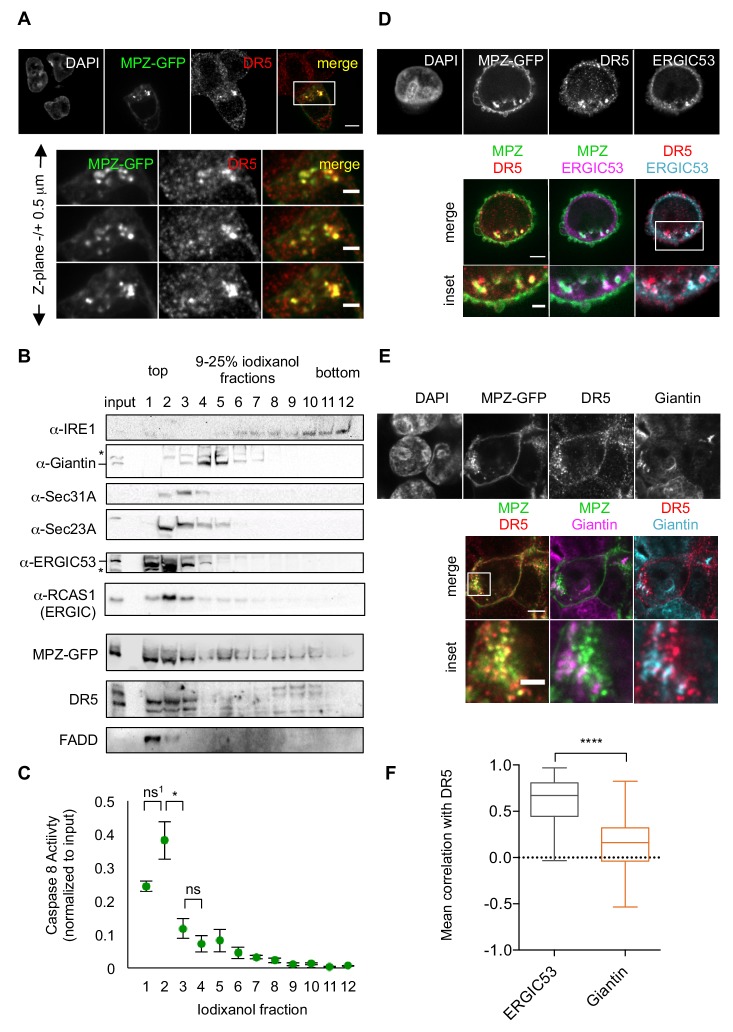
Misfolded protein engages DR5 at the ER-Golgi intermediate compartment, inducing active DR5 signaling clusters.(A) Top: Immunofluorescence of HCT116 cells transfected with MPZ-GFP (green) for 24 hr and stained with anti-DR5 (red, scale bar 5 μm). Bottom: Enlargements of the inset stepping through the z-plane in 0.5 μm increments (scale bar 2 μm). (B) Subcellular fractionation of lysate expressing MPZ-GFP, where IRE1 marks the ER, Giantin marks the Golgi, Sec31A and Sec23A mark COPII vesicles, and ERGIC53 and RCAS1 correspond to ER-Golgi intermediate compartment. Bands of the expected size are indicated by “– “and bands that may represent a modified or degraded protein are indicated by *. (C) Average caspase activity of each fraction from subcellular gradient centrifugation in (B) normalized to total lysate (input) measured by caspase 8 substrate luminescence (n = 3 biological replicates, error bars = SEM; ns1 indicates p=0.079, * denotes p=0.015, and ns indicates p=0.31 from unpaired t-tests with equal SD). (D) Top: Immunostaining of DR5 and ERGIC53 in fixed HCT116 cells transfected with MPZ-GFP for 24 hr as in (A). Bottom: Merged images with ERGIC53 in magenta or cyan to depict overlapping signal as white (scale bar = 5 μm, insets scale bar = 2 μm). (E) Immunostaining of DR5 and giantin in fixed HCT116 cells expressing MPZ-GFP. Giantin is magenta in the overlay with MPZ (green) or cyan in the overlay with DR5 (red). Bottom row enlarges the inset marked in the merges images to show little overlapping signal with giantin (scale bar = 5 μm, inset scale bar = 1 μm). (F) Box-whisker plots quantifying the Pearson’s correlation per cell between DR5 and ERGIC53 (mean = 0.61 ± 0.03) or giantin (mean = 0.14 ± 0.02) within MPZ-positive cells (N > 55), where whiskers correspond to minimum and maximum values of the data (**** indicates p<0.001).Figure 2—source data 1.Caspase activity for fractions of iodixanol gradient.This excel file contains the caspase glo 8 luminescent units of the fractionation samples (n = 3 biological replicates) shown in Figure 2C.